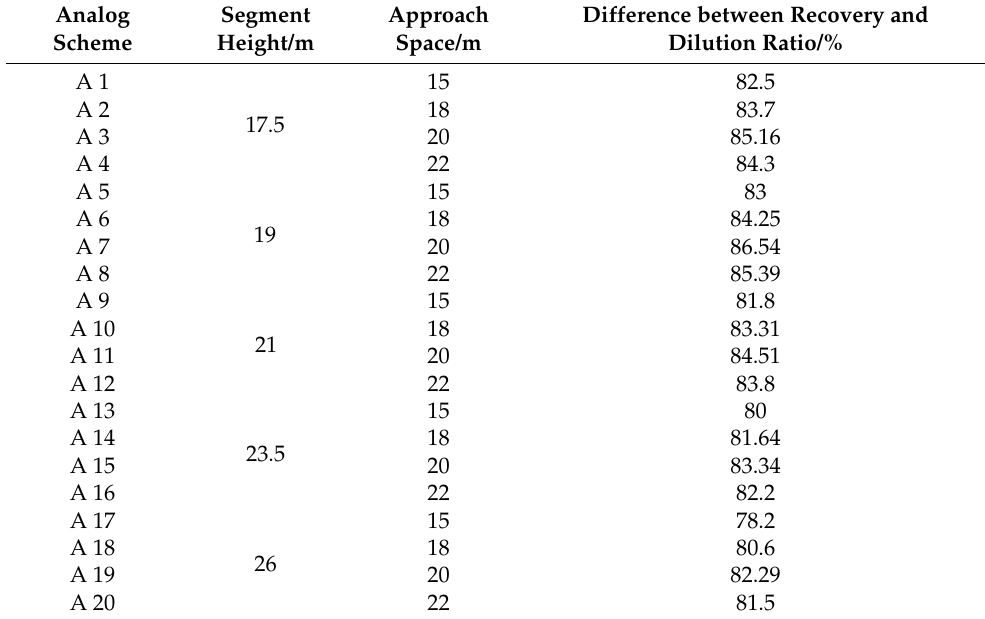
Table 2. Statistical table of ore drawing results of each simulation scheme.